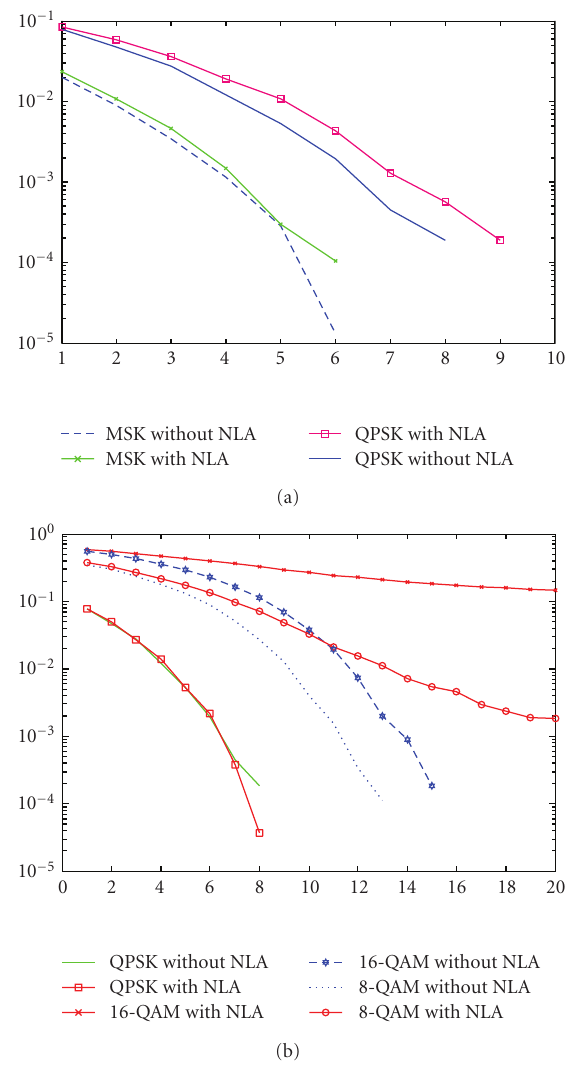
Figure 12: (a) E ff ect of NLA on MSK and QPSK. (b) E ff ect of NLA on M -QAM.